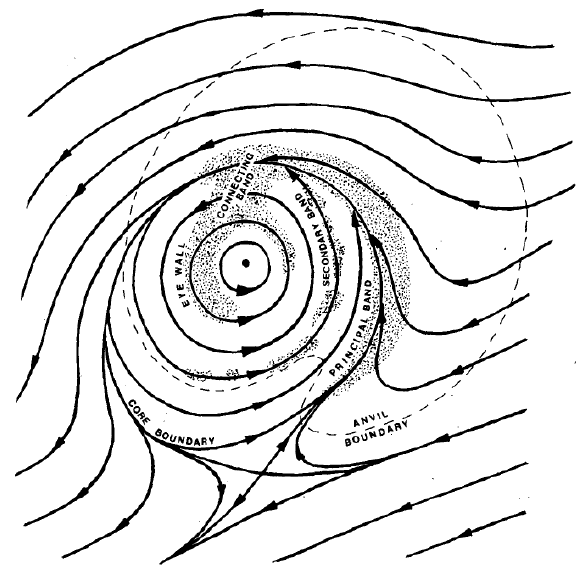
Figure 1. Willoughby et al.’s hypothesized flow topology of a mature TC in northeasterly storm-relative flow above the layer of strong inflow (approx. 850 hPa, their Fig. 18). The closed gyre around the center is supposed to contain the moist ’vortex air’ while drier environmental air is found outside the dividing streamline. The shading indicates regions of deep convection. The principal, secondary, and connecting band constitute the so-called stationary band complex.